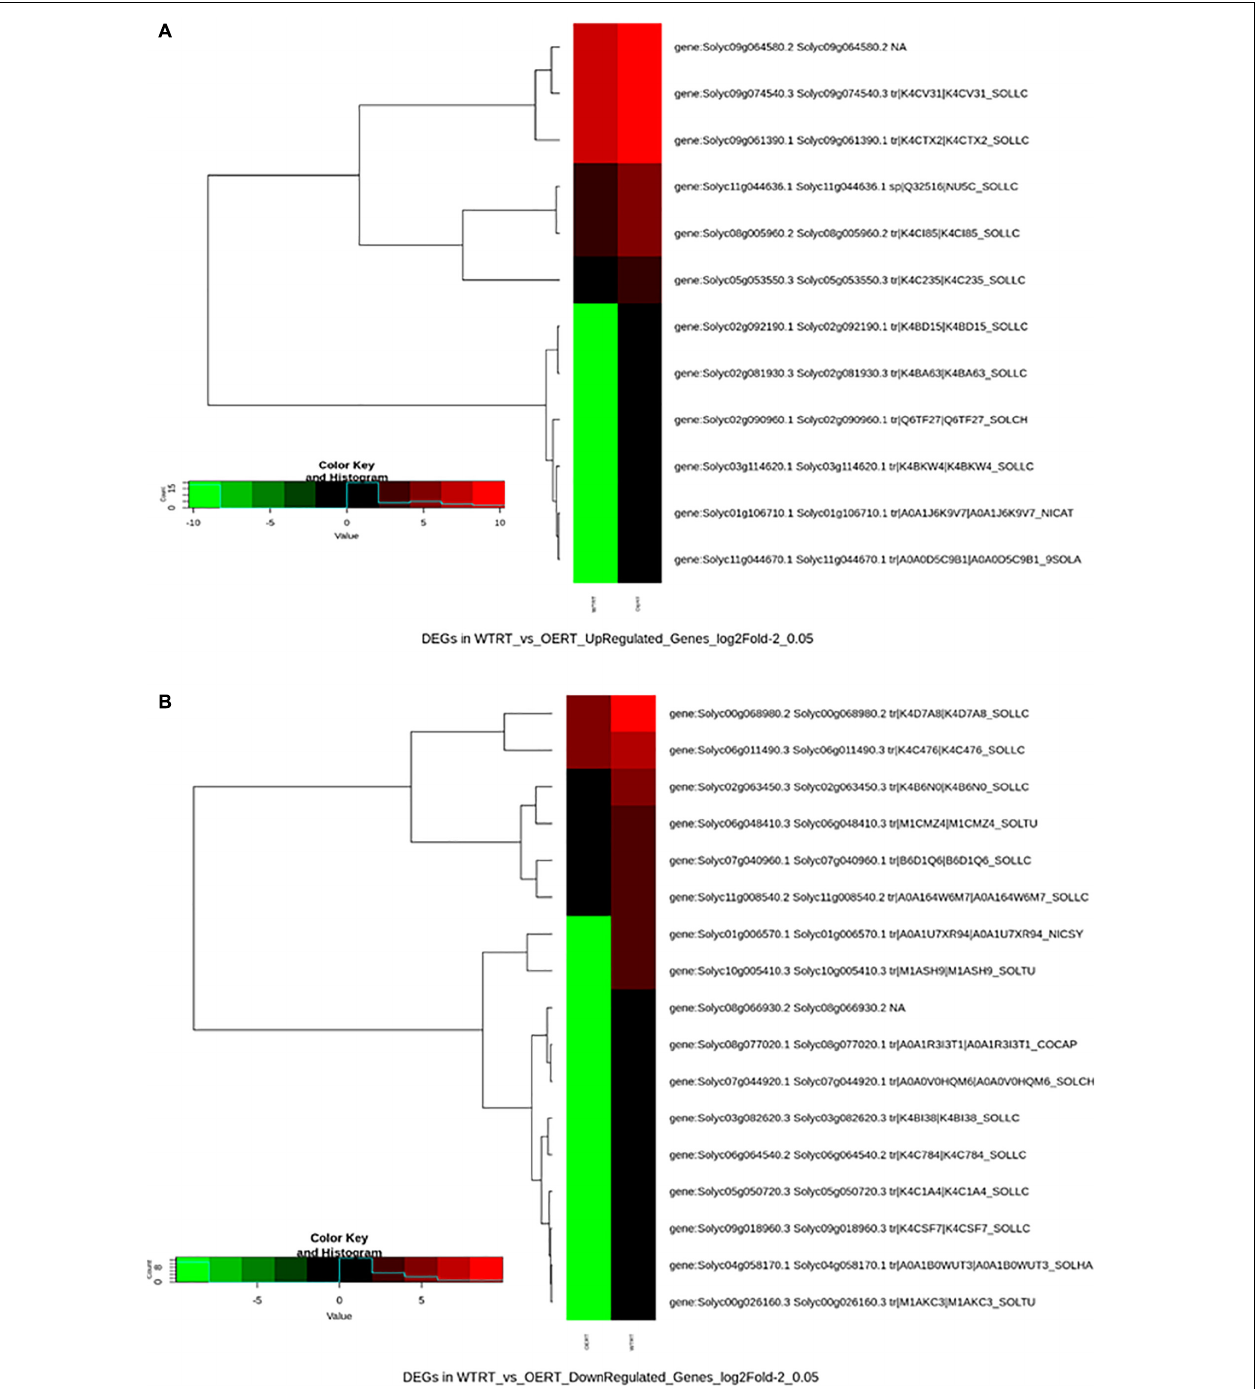
FIGURE 7 | Heat map of differentially expressed genes (DEGs) in SmHSP24.1 overexpressed transgenic (OE) and wild type (WT) lines under control conditions . (A) Heatmap generated from differentially expressed upregulated genes in OERT vs. WTRT lines. (B) Heatmap generated from differentially expressed down-regulated genes in OERT vs. WTRT